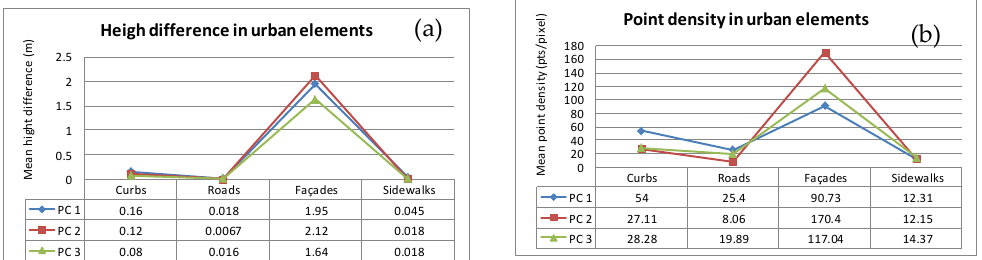
Figure 4. Height difference ( a ) and mean point density ( b ) of four urban elements in three different point clouds (PC).